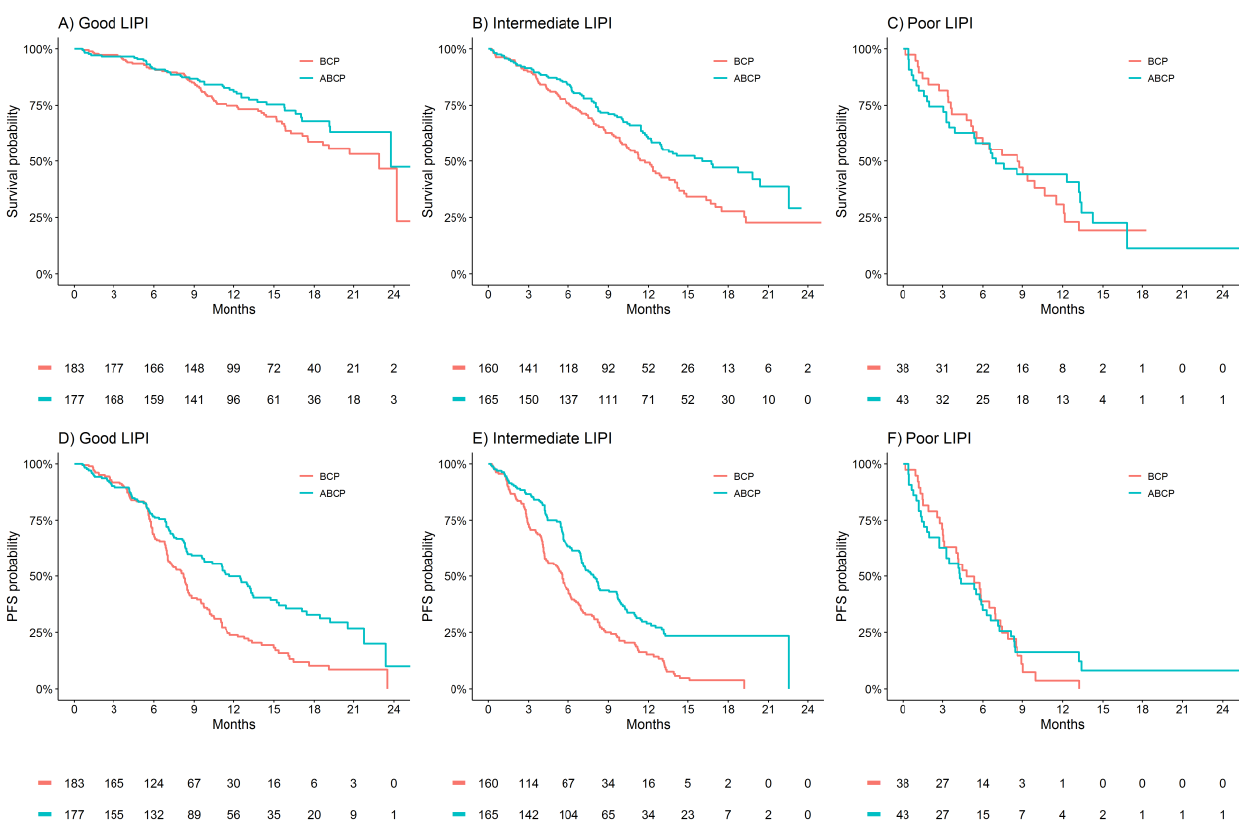
Figure 2. Kaplan–Meier estimates of overall survival and progression-free survival in the randomized arms of IMpower150 (ABCP versus BCP), subgrouped by LIPI. ( A ) Good LIPI—ABCP vs. BCP ( B ) Intermediate LIPI—ABCP vs. BCP ( C ) Poor LIPI—ABCP vs. BCP ( D ) Good LIPI—ACP vs. BCP ( E ) Intermediate LIPI—ACP vs. BCP ( F ) Poor LIPI—ACP vs. BCP.